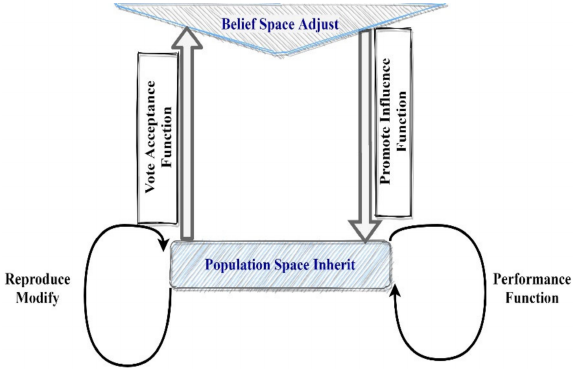
Figure 3. Components of culture algorithm.